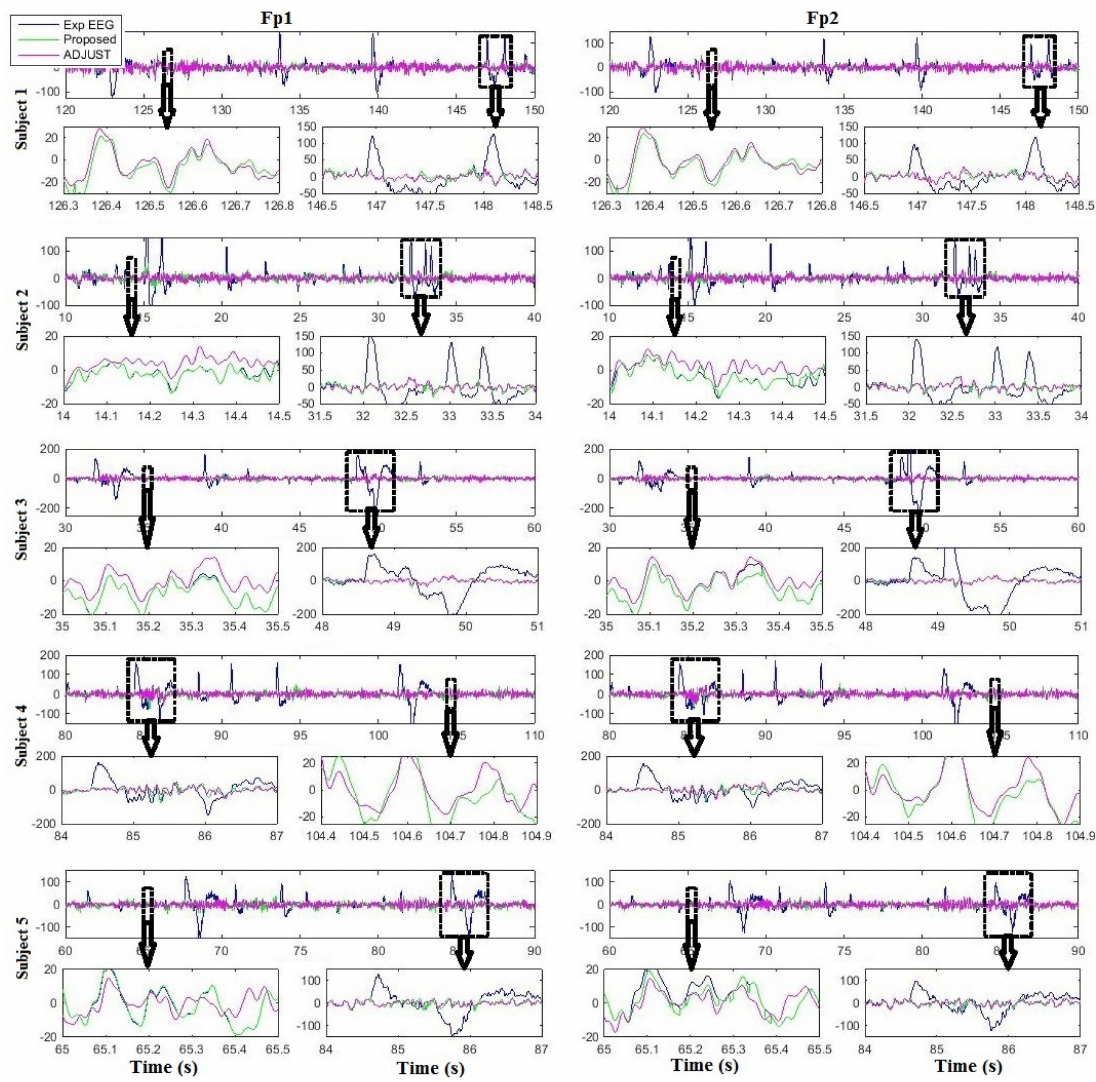
Figure 7. Comparison results of the proposed algorithm and ADJUST for all subjects at Fp1 and